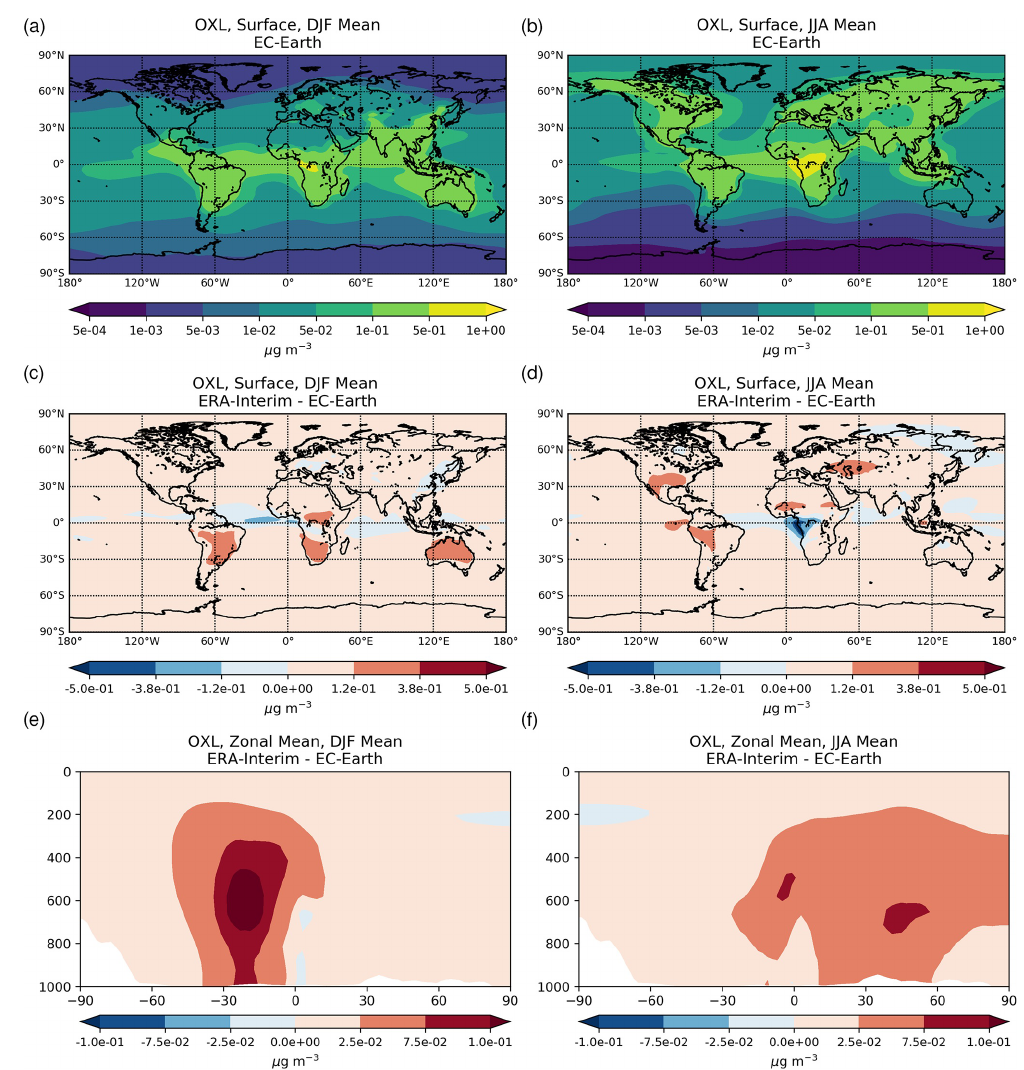
Figure 5. Oxalate (OXL) surface concentrations (µgm − 3 ) for the boreal winter (DJF; a ) and boreal summer (JJA; b ), as simulated for the EC-Earth simulation averaged for the period 2000–2014, and the respective absolute differences to the ERA-Interim simulation for surface (c, d) and zonal mean (e, f)